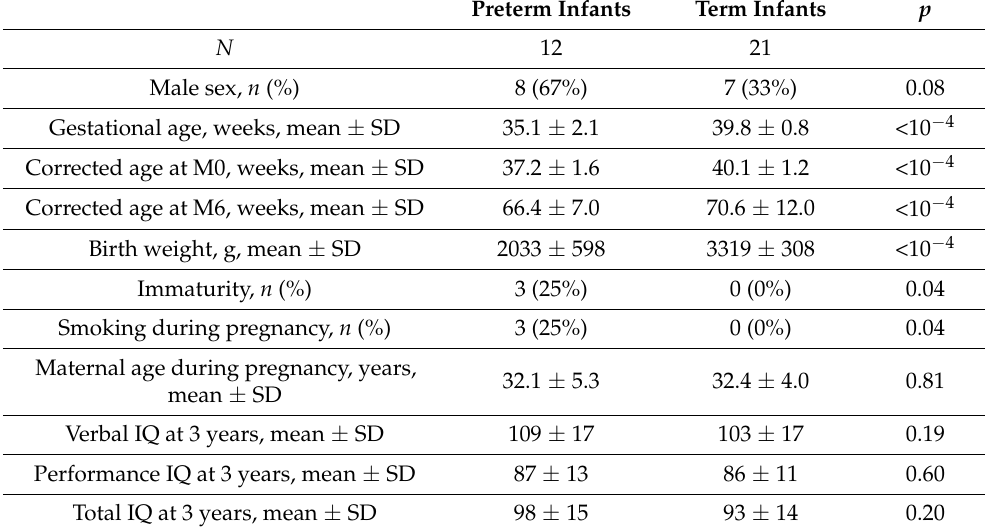
Preterm Infants